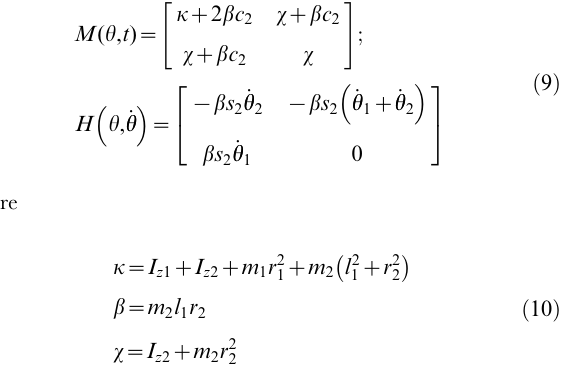
shoulder joint, and subscript ‘‘i= 2’’ identifies forearm-hand link and elbow joint variables. l i is the length of the i th link; m i is its mass, r i is the distance between the i th link center of mass and the i th joint, and I zi are the moments of inertia about the z-axis orthogonal to the plane of movement calculated at the i th link’s center of mass. We use simplified notation for trigonometric functions with s 2 ~ sin h 2 ð Þ and c 2 ~ cos h 2 ð Þ .